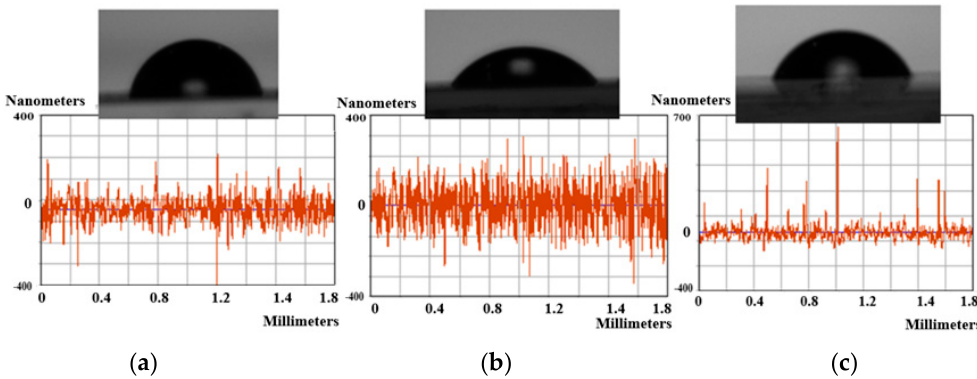
Figure 6. Surface modification results: top figures—contact angle images; bottom figures—profiler roughness measurements of samples: ( a ) P0; ( b ) P1; ( c ) P2.